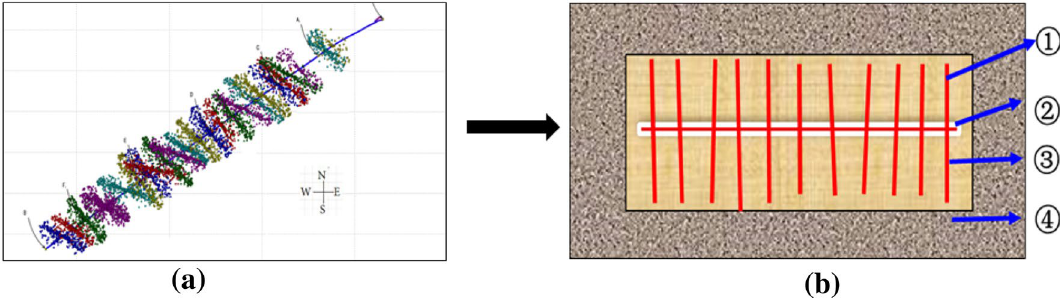
Fig. 1 a Microseismic data showing the complex fractures in Jimsar sag, Xinjiang oilfield; b schematic of a fracture